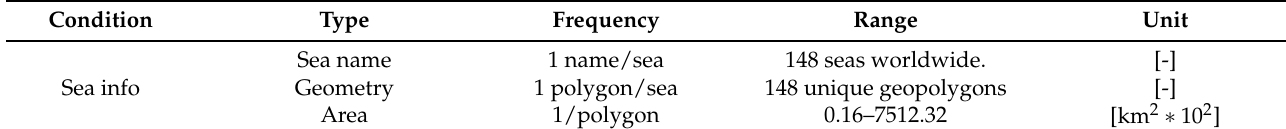
Table 4. Sampling frequency, range and units of IHO seas data.